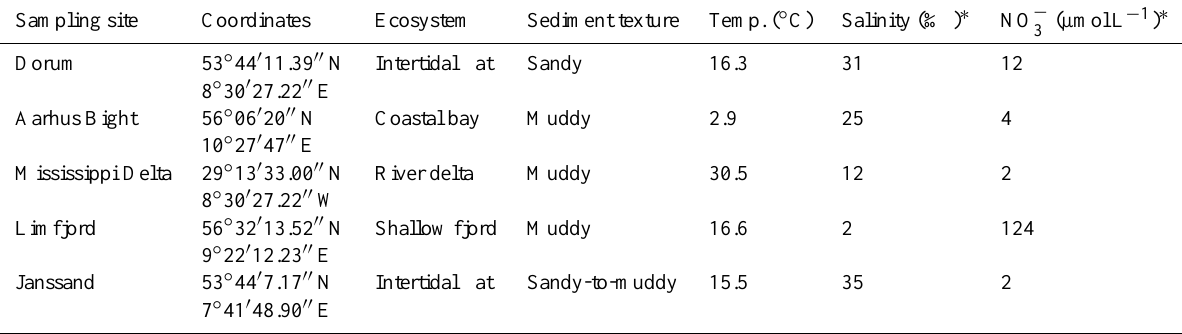
Table 1. Location and characteristics of sampling